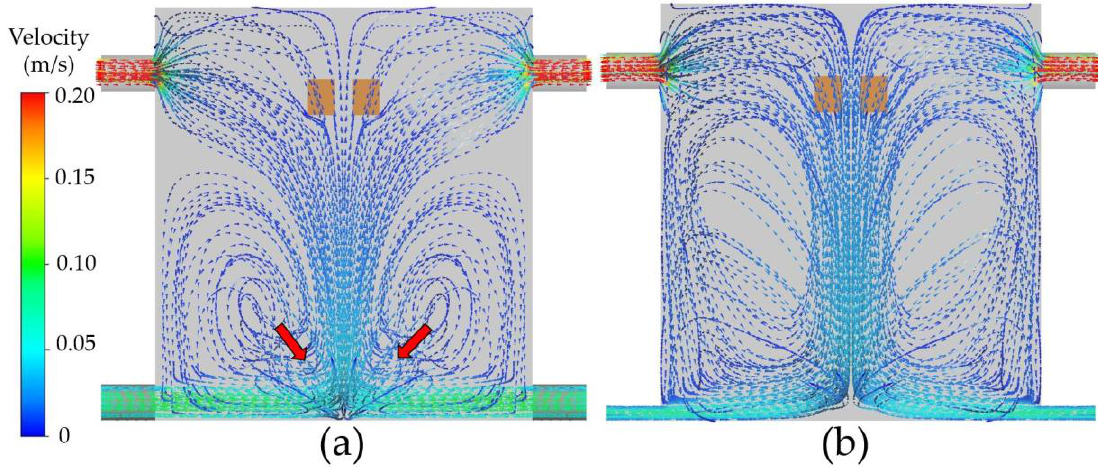
Figure 11. Water circulation system’s streamlines for ( a ) circular inlet and ( b ) rectangular inlet.